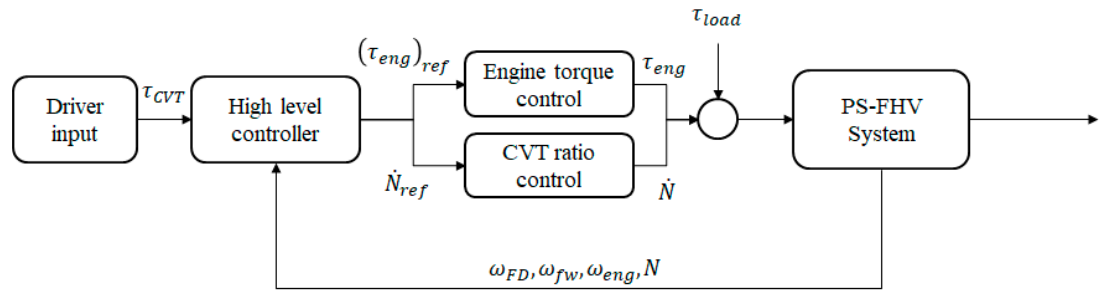
Figure 9. The PS-FHV control block diagram.